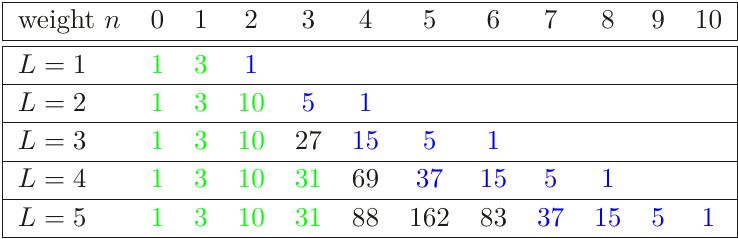
Table 1. The number of independent { n, 1 , 1 , . . . , 1 } coproducts of the form factor E ( L ) through L = 5 loops. A green number denotes saturation of the space M constructed from the bottom up. A blue number denotes saturation of the space of coproducts, as indicated by the ( L, n ) number being the same as the ( L + 1 , n + 2) number.